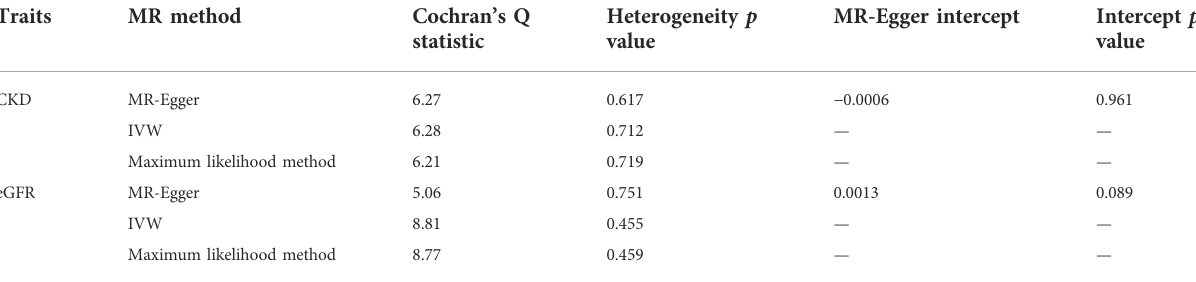
TABLE 1 MR estimates from each method of the causal effect of adiponectin on kidney function.